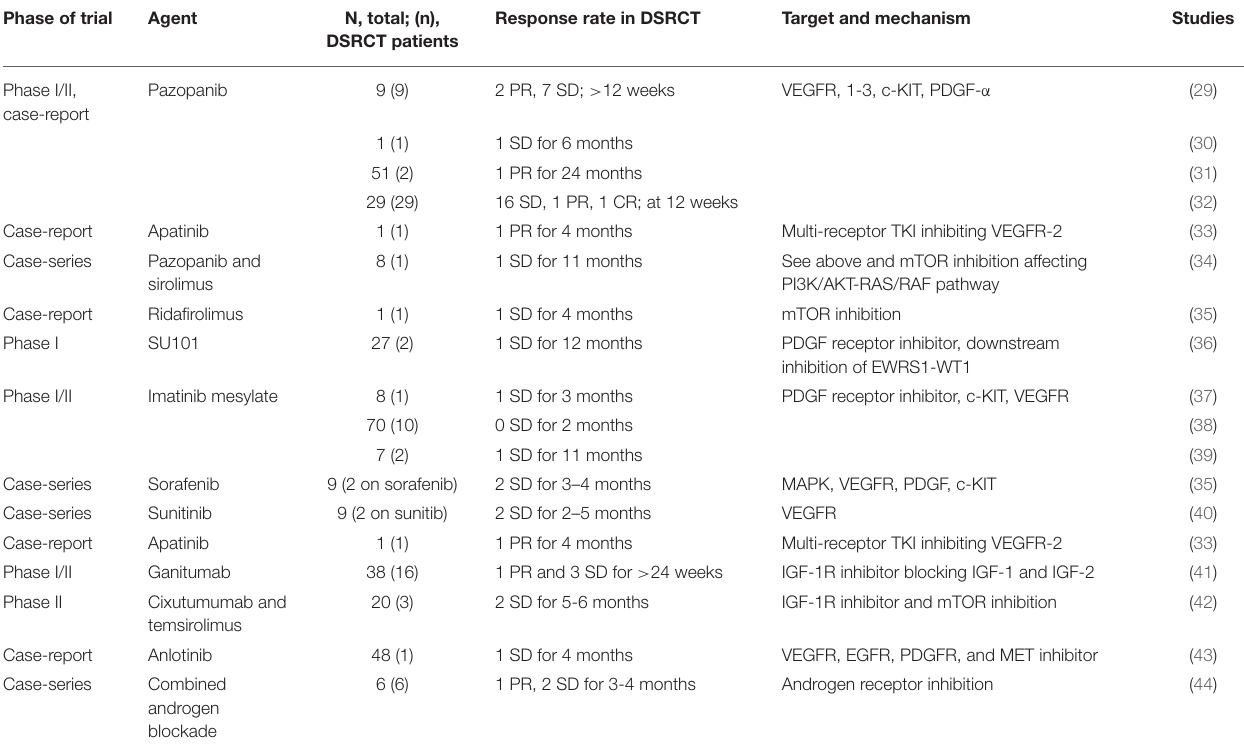
TABLE 1 | Selected trials and case-reports including desmoplastic small round cell tumor. Phase of